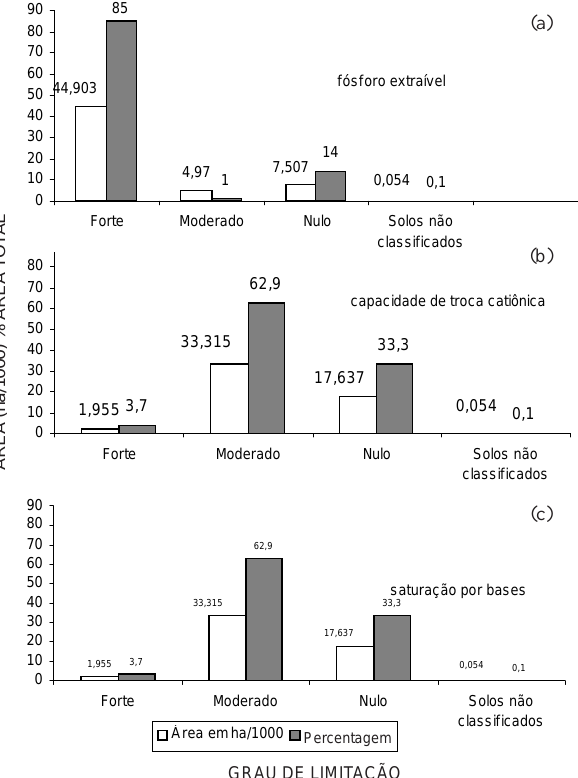
Figura 3. Distribuição das áreas da Bacia do rio Jardim (DF) quanto ao grau de limitação das propriedades selecionadas para a definição do fator fertilidade para a cultura do milho, em hectares e percentagem da área